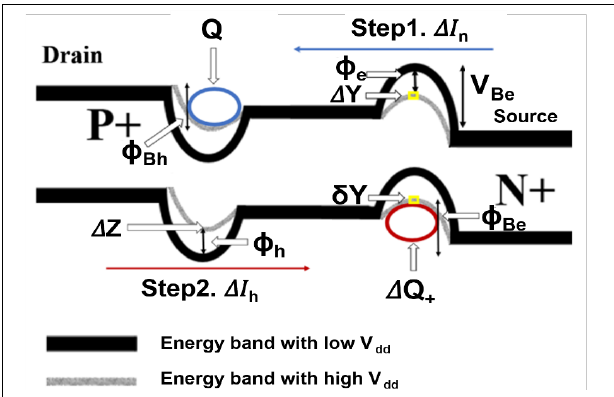
Figure 3. Positive feedback mechanism: the operational principles are divided into two steps [65].